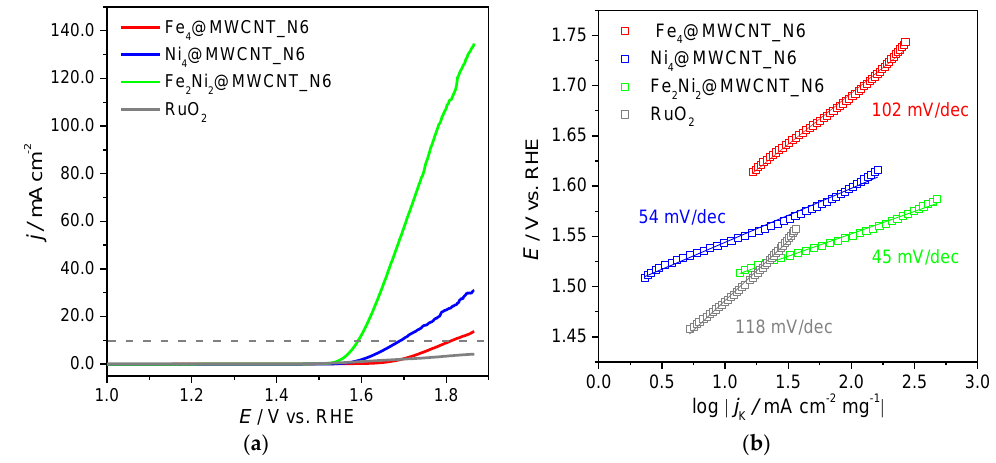
Figure 5. LSV OER curves ( a ) and Tafel plots ( b ) of Fe 4 @MWCNT_N6, Ni 4 @MWCNT_N6